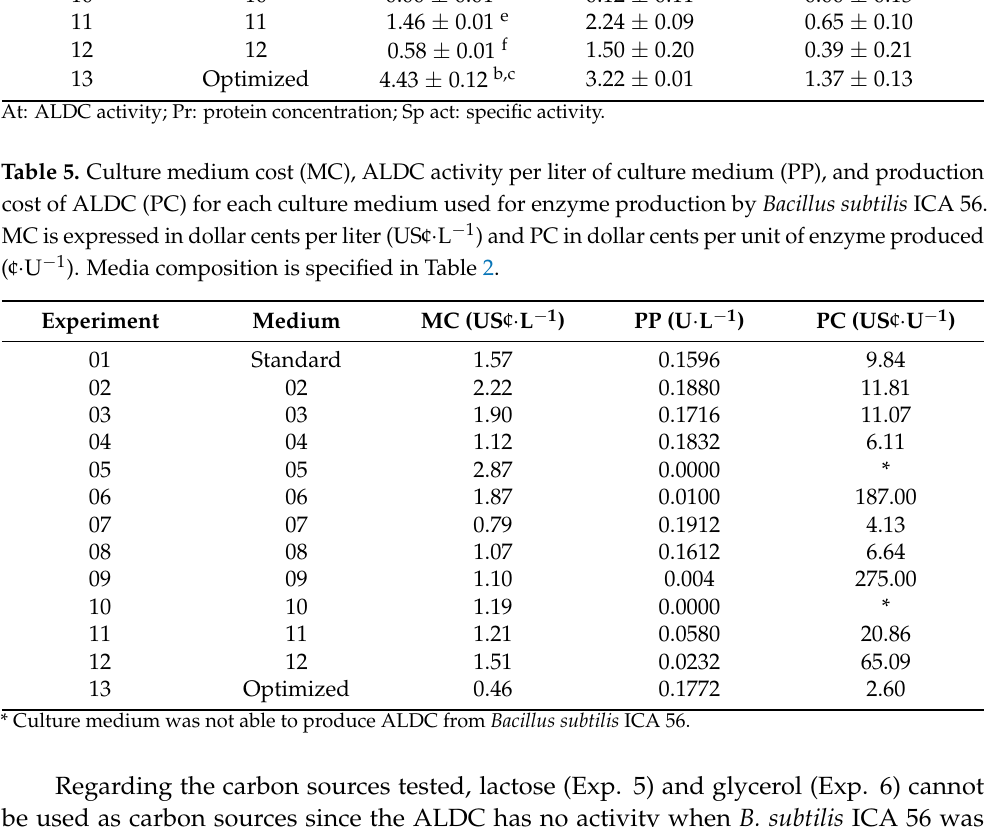
Table 2. Concentrations and costs in dollar cents (US¢) of each medium component used in the different shake flask cultures studied, namely standard medium (experiment 1), medium 2 (experiment 2), medium 3 (experiment 3), medium 4 (experiment 4), medium 5 (experiment 5), medium 6 (experiment 6), medium 7 (experiment 7), medium 8 (experiment 8), medium